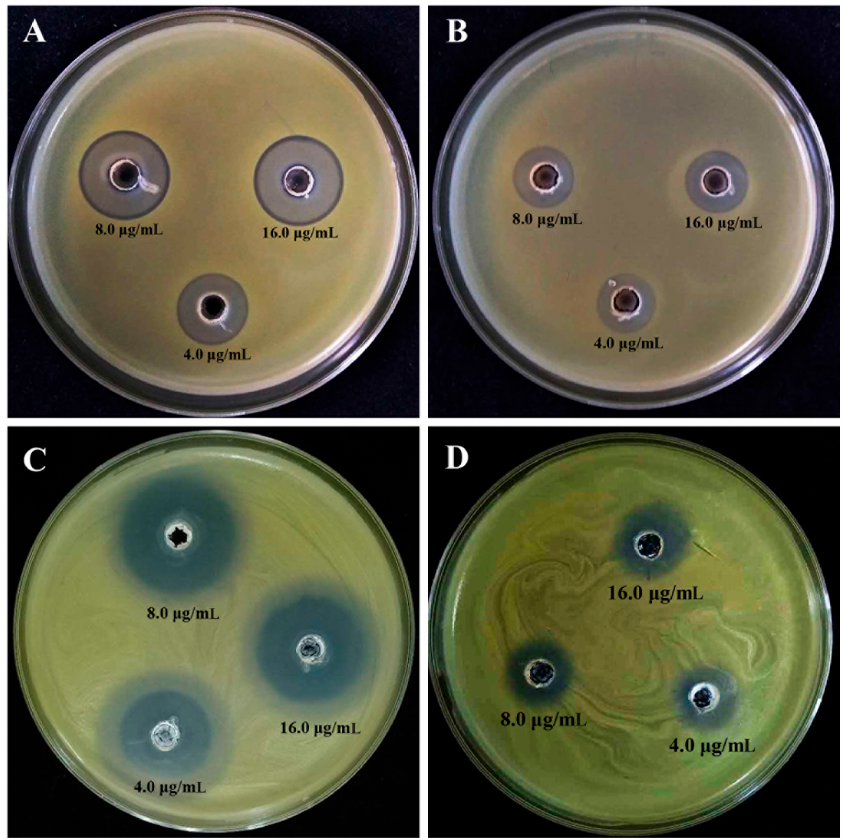
Figure 5. The in vitro inhibitory effect of ( A ) CSNPs, ( B ) bulk CS, ( C ) ZnONPs, and ( D ) bulk ZnO on the growth of Xanthomonas oryzae pv. oryzae strain GZ0005 following 24 h of incubation at 30 °C. Table 1. The inhibitory effect of bulk chitosan (CS), chitosan nanoparticles (CSNPs), bulk ZnO, and zinc oxide nanoparticles (ZnONPs) on the growth of Xanthomonas oryzae pv. oryzae strain GZ0005 in nutrient agar plates.